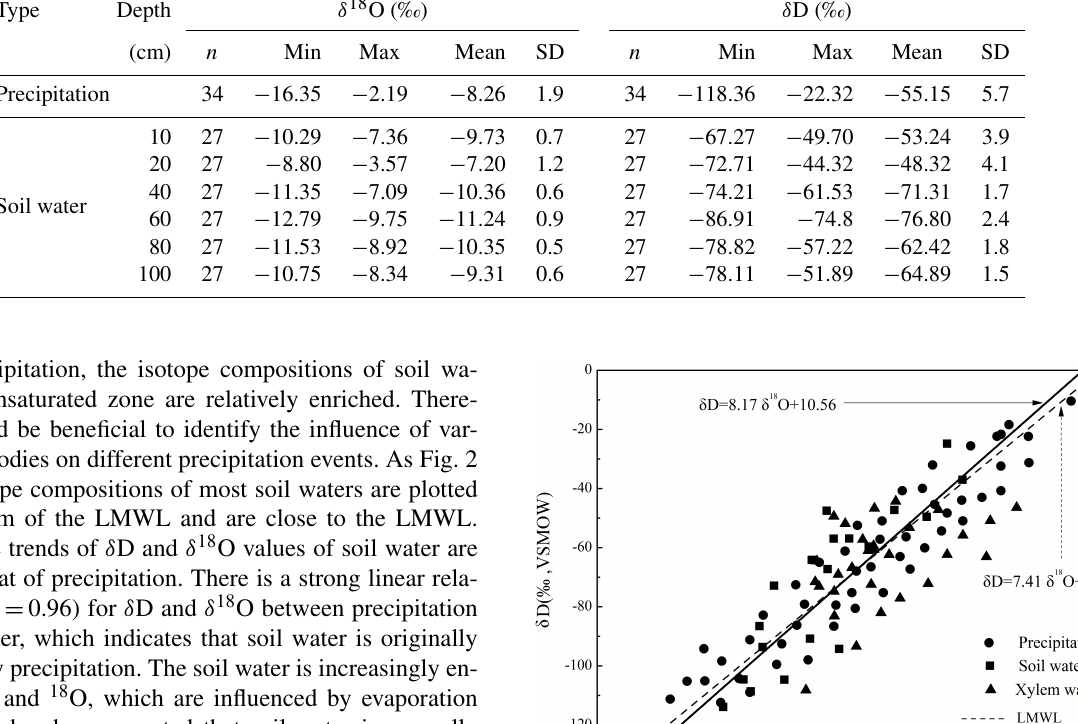
Table 1. Statistic characteristics of isotopic compositions for precipitation and soil water in the study area. Type